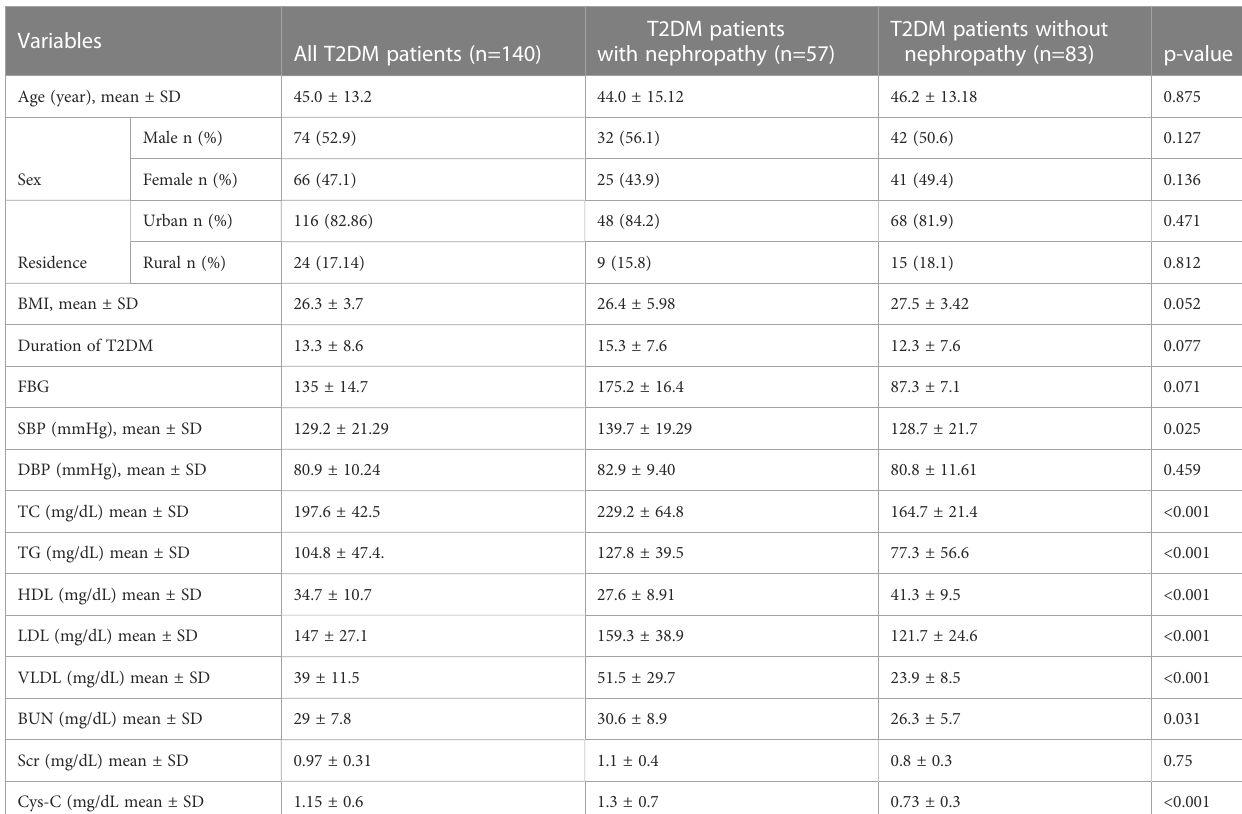
TABLE 1 Socio-demographic and clinical pro fi les of T2DM patients with and without nephropathy.